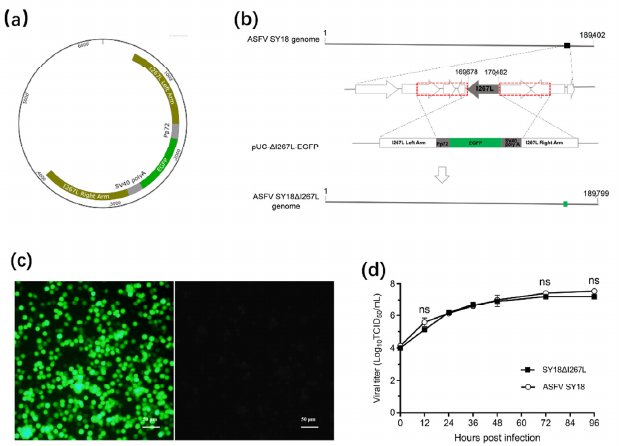
Figure 3. Construction of SY18 ∆ I267L. ( a ) The recombinant plasmid, pUC- ∆ I267L-EGFP, was con- structed. ( b ) Schematic representation of SY18 Δ I226R construction. The location of the I267L gene was replaced with the EGFP cassette via homologous recombination between pUC- Δ I267L-EGFP and ASFV SY18 genomic DNA in vitro. The red dotted frame represents the position of the homology arms and the green square represents the position of EGFP. ( c ) BMDMs were infected with purified SY18 Δ I267L and expressed green fluorescence (Left). The mock-infected BMDMs were non-fluorescence (Right). Bar 50 μ m. ( d ) The viral titers of the two viruses were measured at 0, 12, 24, 36, 48, 72, and 96 hpi and exhibited using log 10 TCID 50 /mL. They were non-significant differences (ns) at specific times (“ns” p ≥ 0.05).